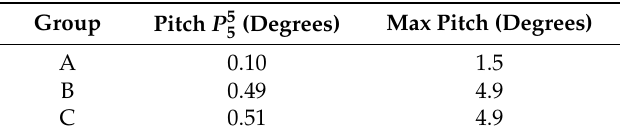
Table 3. Pitch P 5 values. The maximum values are the average of the peak pitch values for the five 5 repetitions in each